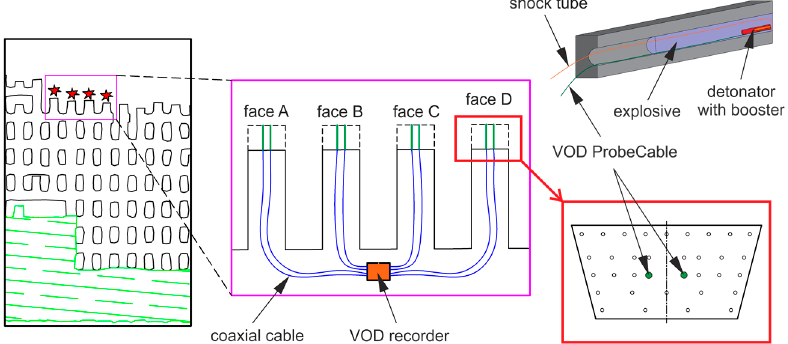
Figure 5. Scheme of the VOD measurements in blastholes with construction of the explosive charge.